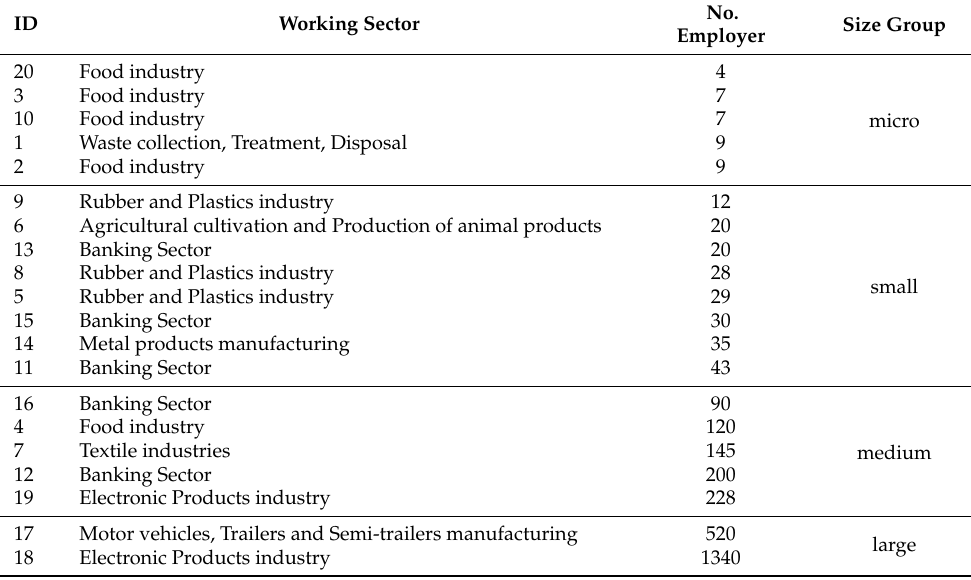
Table 1. Sample size of the enrolled